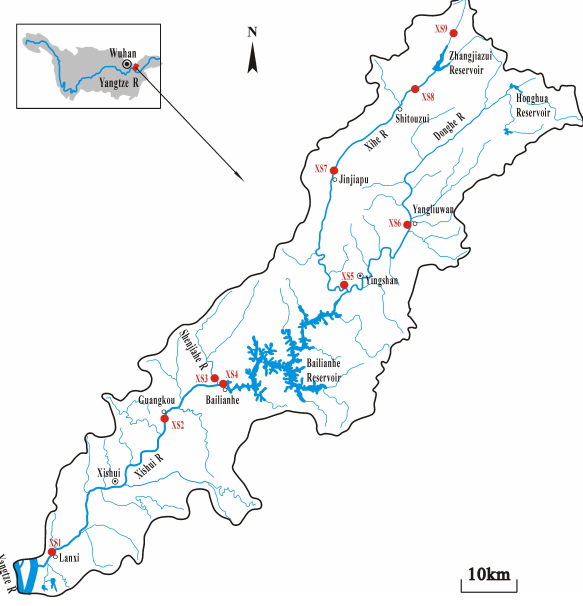
Fig. 1. Map of the Xishui River catchment and sampling locations (filled red